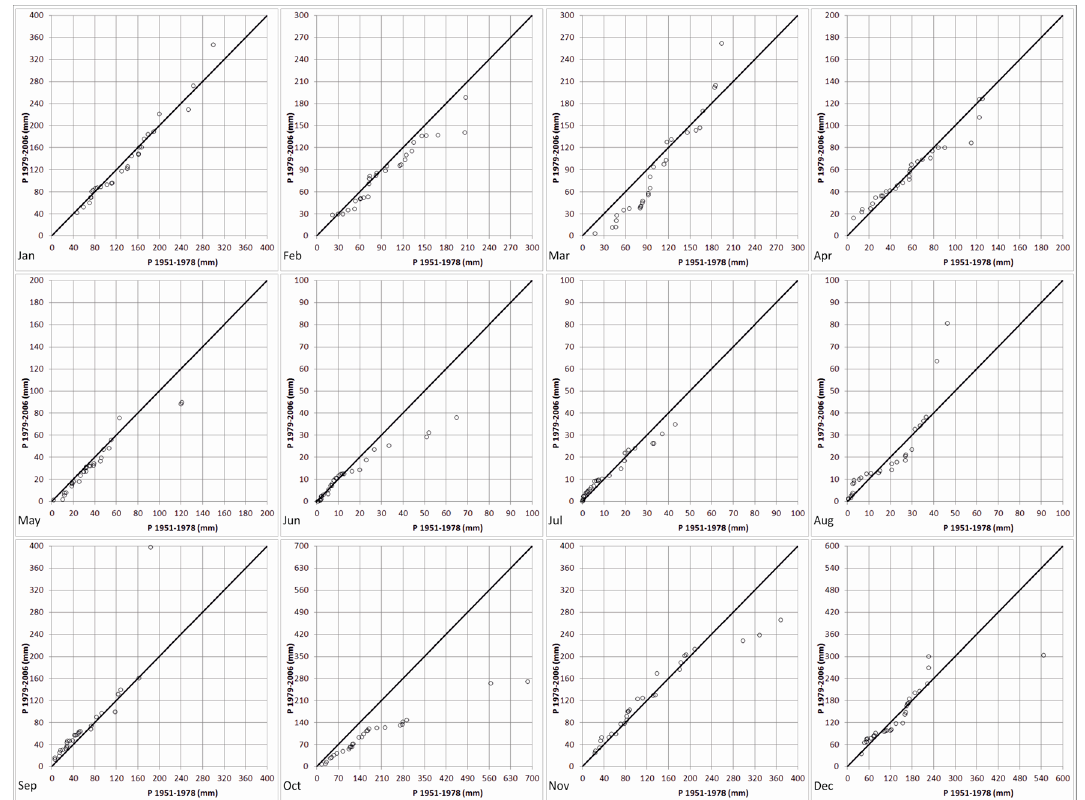
Figure 4. Results of the ITA method for the Rainfall Zone I3 for the period 1951–2006.